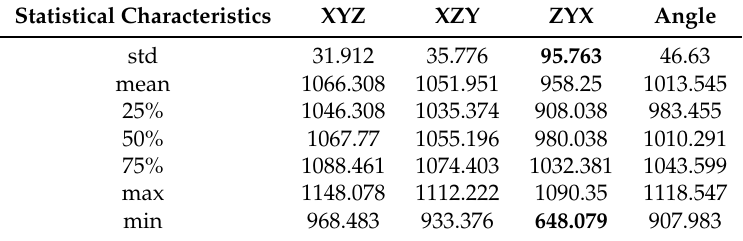
Table 2. Statistical data evaluation for Tensile modulus for each orientation separately.